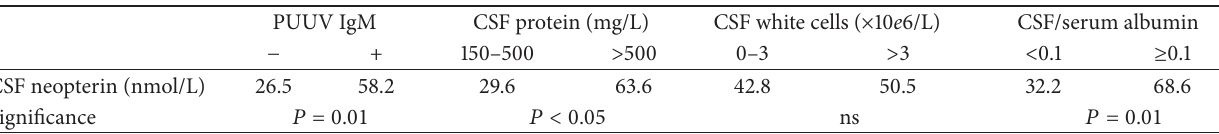
Table 1: Summary of statistical analysis of the CSF neopterin concentration and the CSF PUUV IgM, protein concentration, white cell count, and CSF/serum albumin ratio.